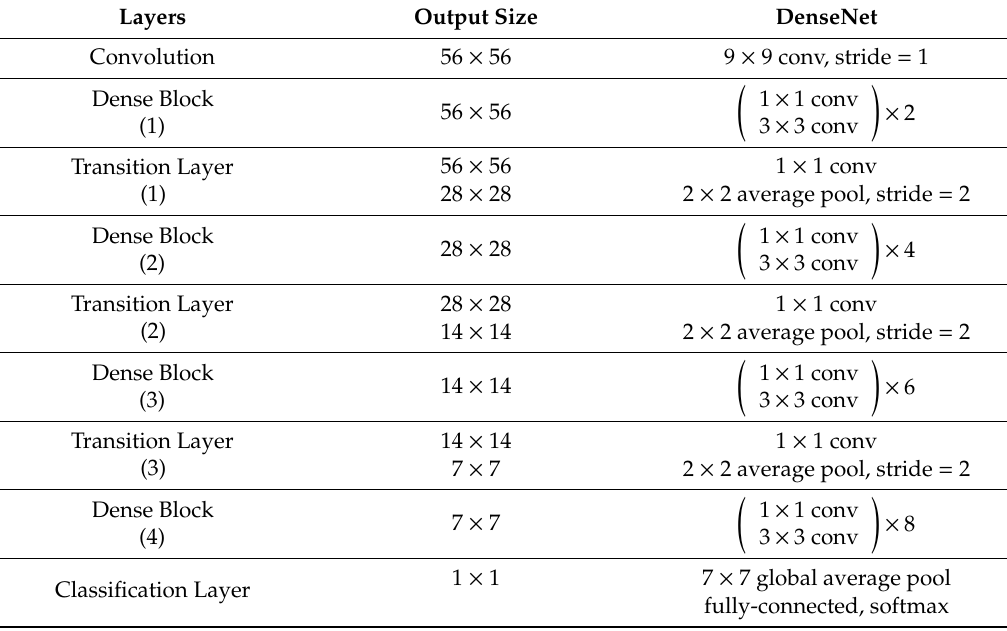
Table 2. The detailed framework of DenseNet.